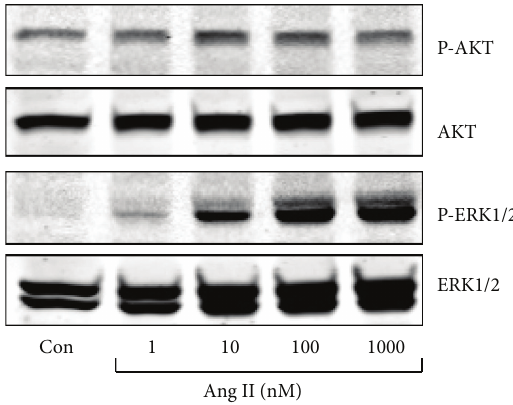
Figure 1: Ang II caused dose-dependent activation of ERK1/2 in H295R cells. Serum-starved H295R cells were treated with Ang II at different doses (1, 10, 100, and 1000 nM) for 5min, then lysed in Laemmli sample buffer, and analyzed by SDS-PAGE using antibody against phospho-ERK1/2 (Thr202/Tyr204) and phospho- AKT (Ser473). The bolt was reprobed with total ERK1/2 and total AKT antibody loading